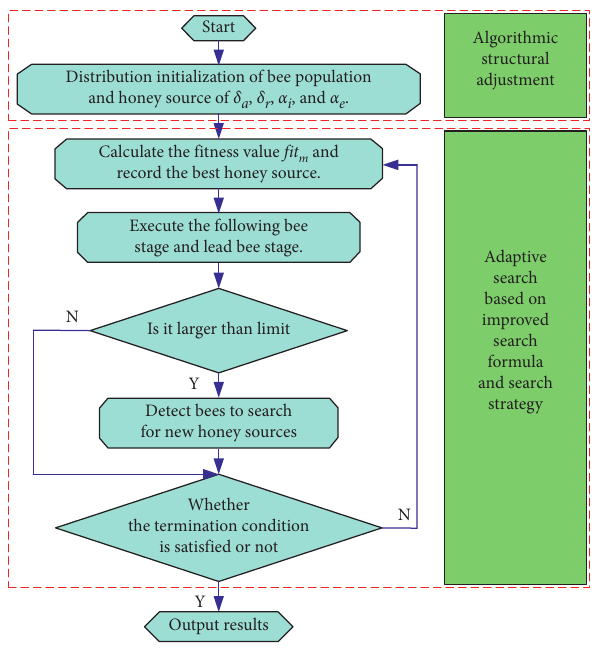
Figure 11: Solution flow chart. Table 5: Structural parameters and material parameters of 218 angular contact ball bearings.